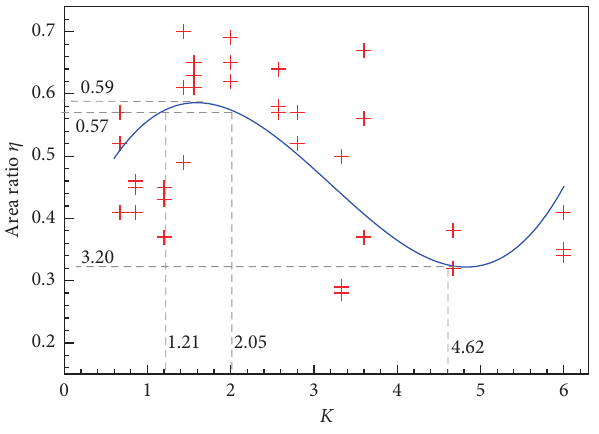
Figure 16: Fitting curve of K and